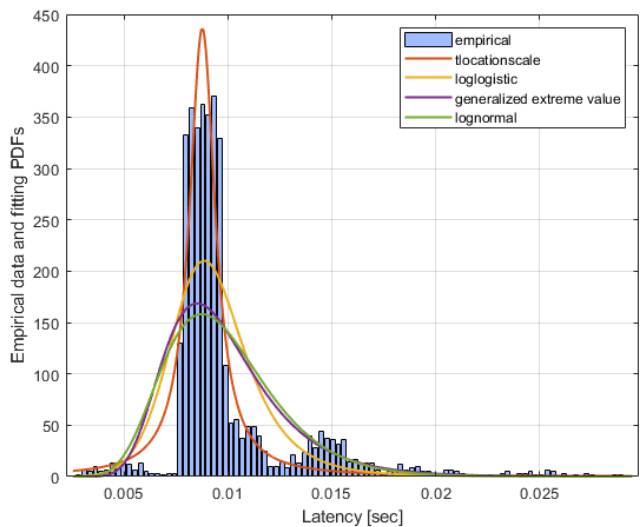
Figure 7. Empirical distribution of the latency of the 5G link only and PDFs of the fitting distributions.